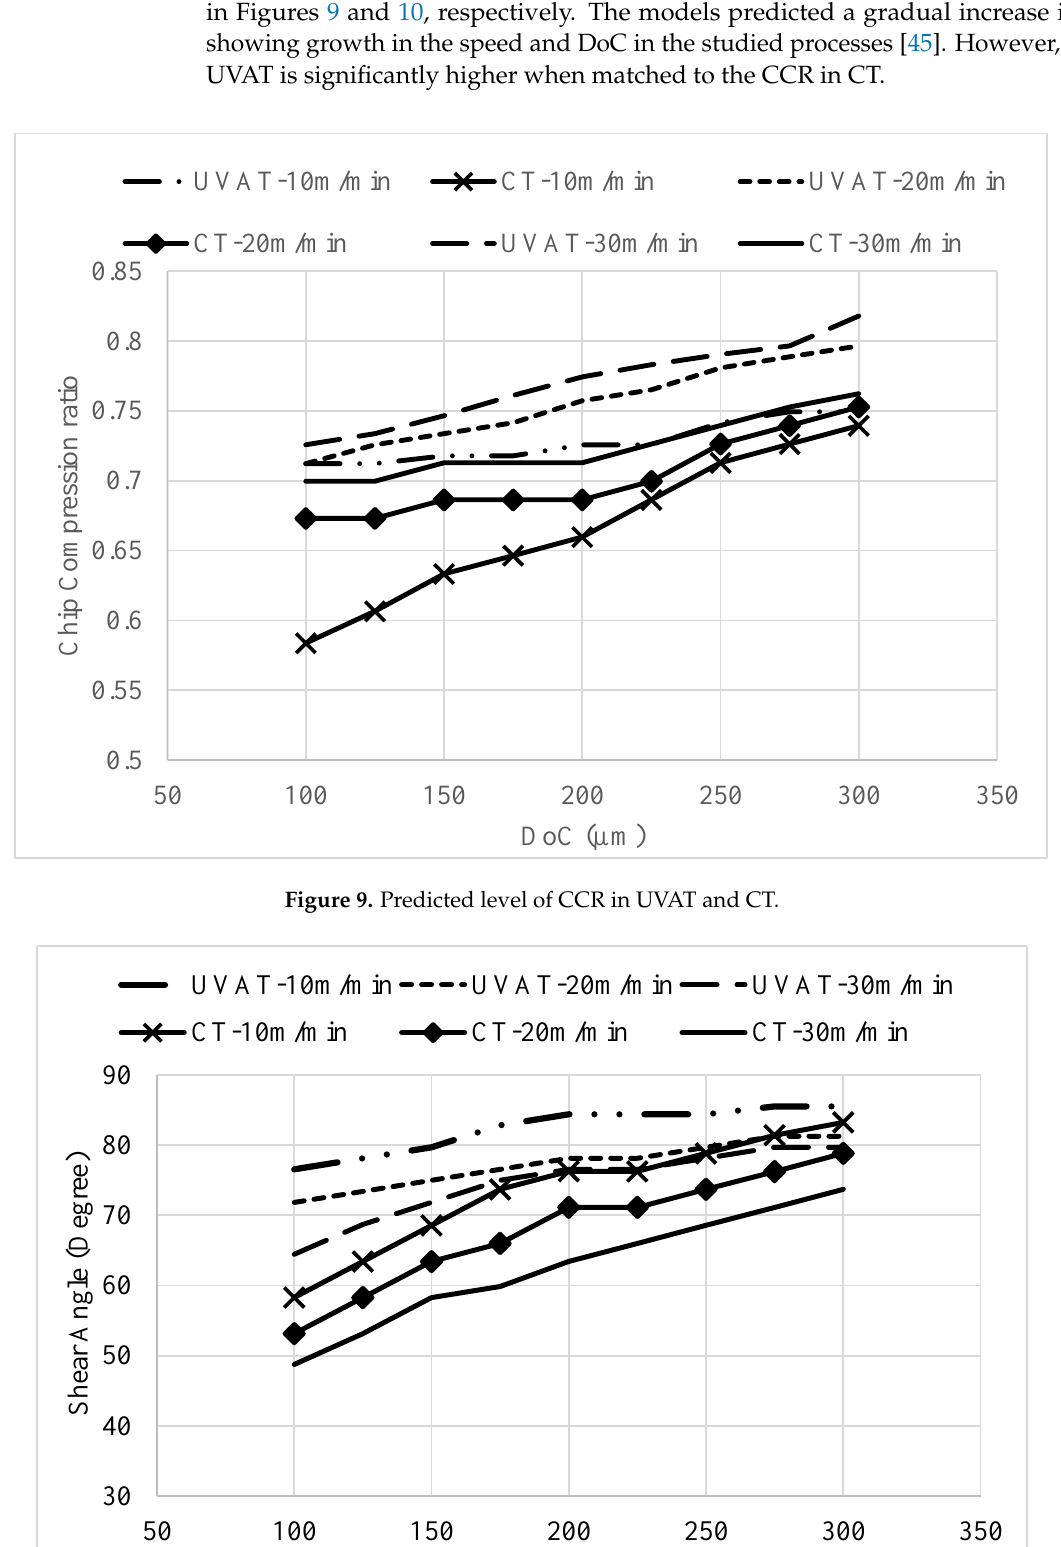
Figure 10. The simulated SA variation with speed and DoC in UVAT and CT.